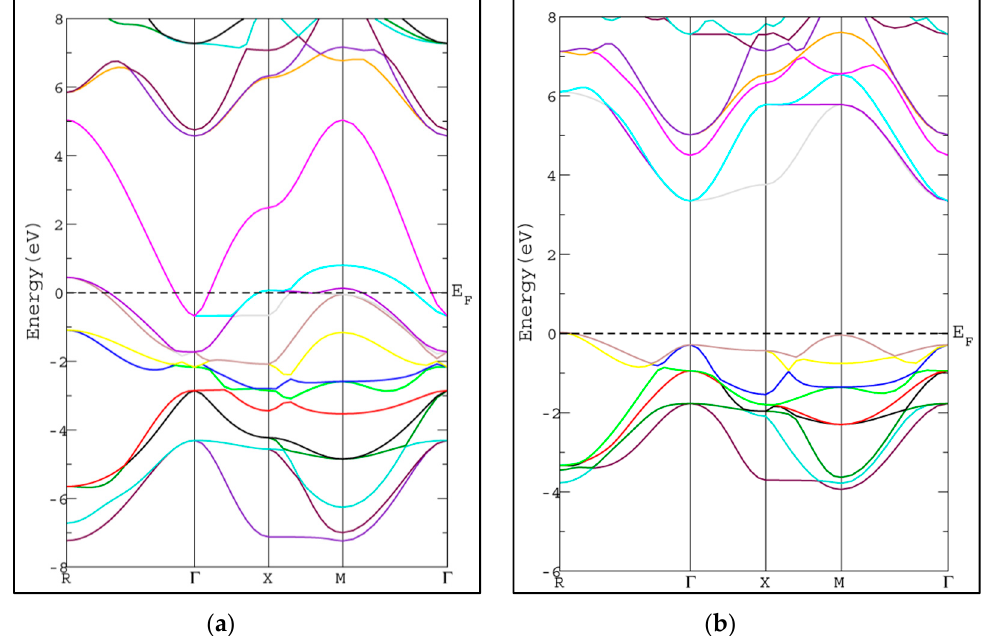
Figure 3. Band structure of cubic pervoskite using PBE-GGA method for ( a ) SrRhO 3 and ( b ) SrZrO 3 compounds.